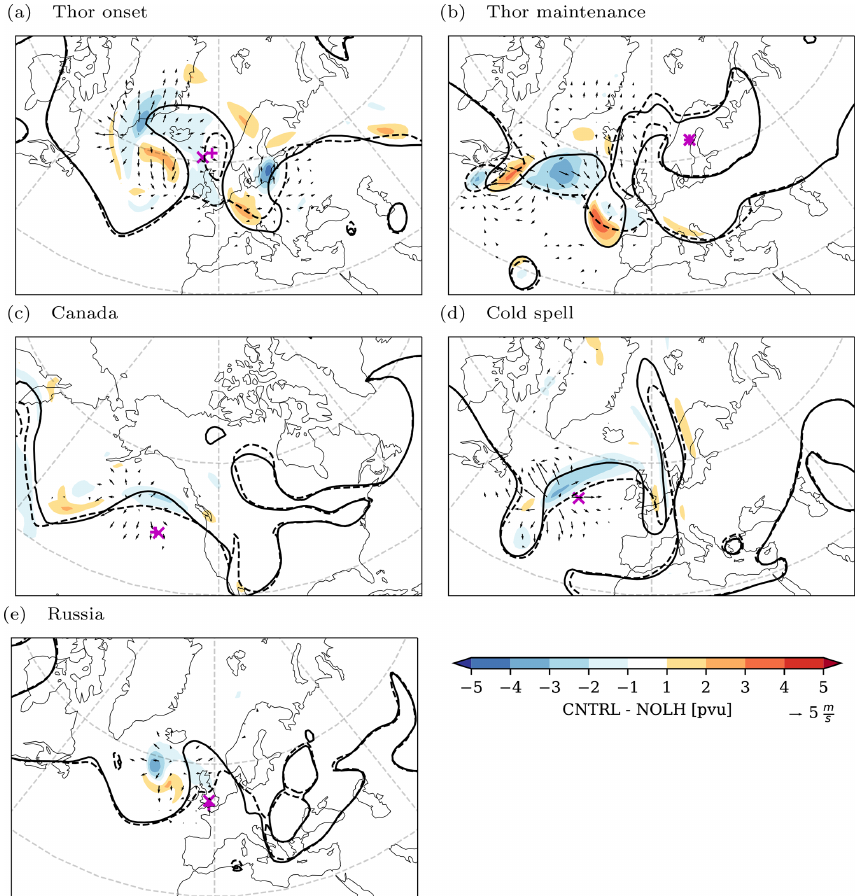
Figure 7. Difference (CNTRL–NOLH) in upper-level PV (shaded in potential vorticity units), difference in upper-level divergent wind (vectors only shown for wind speed larger than 1ms − 1 ), and upper-level 2pvu contour (solid for CNTRL, dashed for NOLH) after 3d model simulation for (a) Thor onset, (b) Thor maintenance, (c) Canada, (d) Cold spell, and (e) Russia. “x” and “ + ” show locations of blocking centers for CNTRL and NOLH,